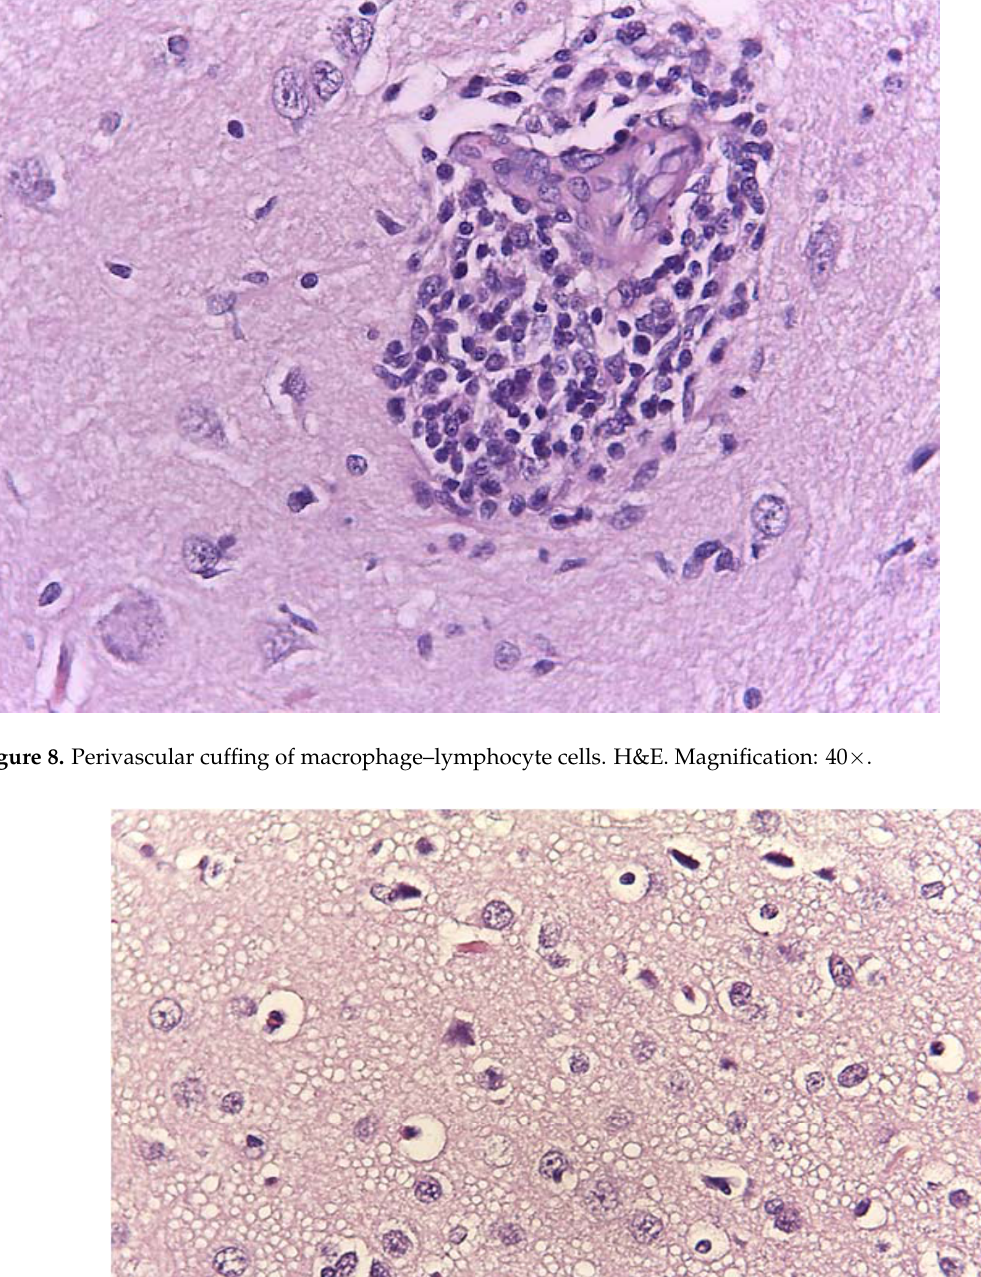
Figure 7. Neurons shrunken and degenerated surrounded by a reactive glia. H&E. Magnification: 40×.